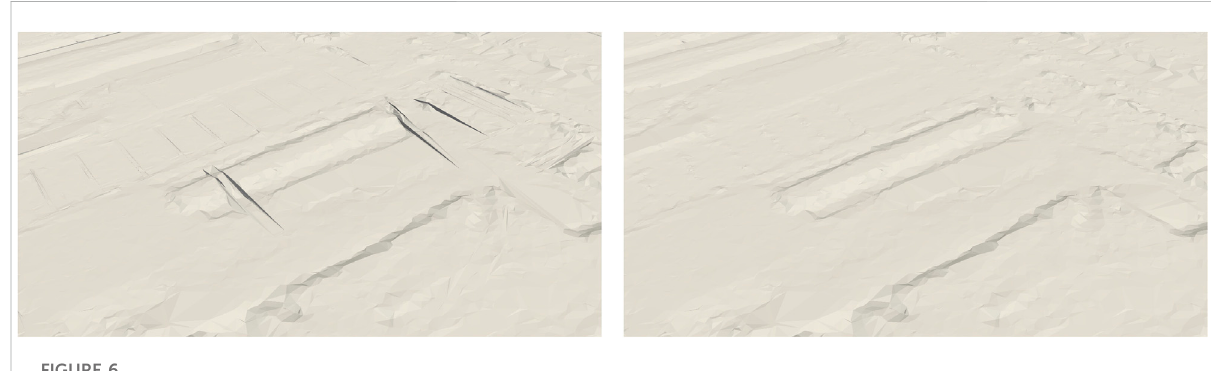
FIGURE 6 Terrain before (left) and after (right) shortening of polygon